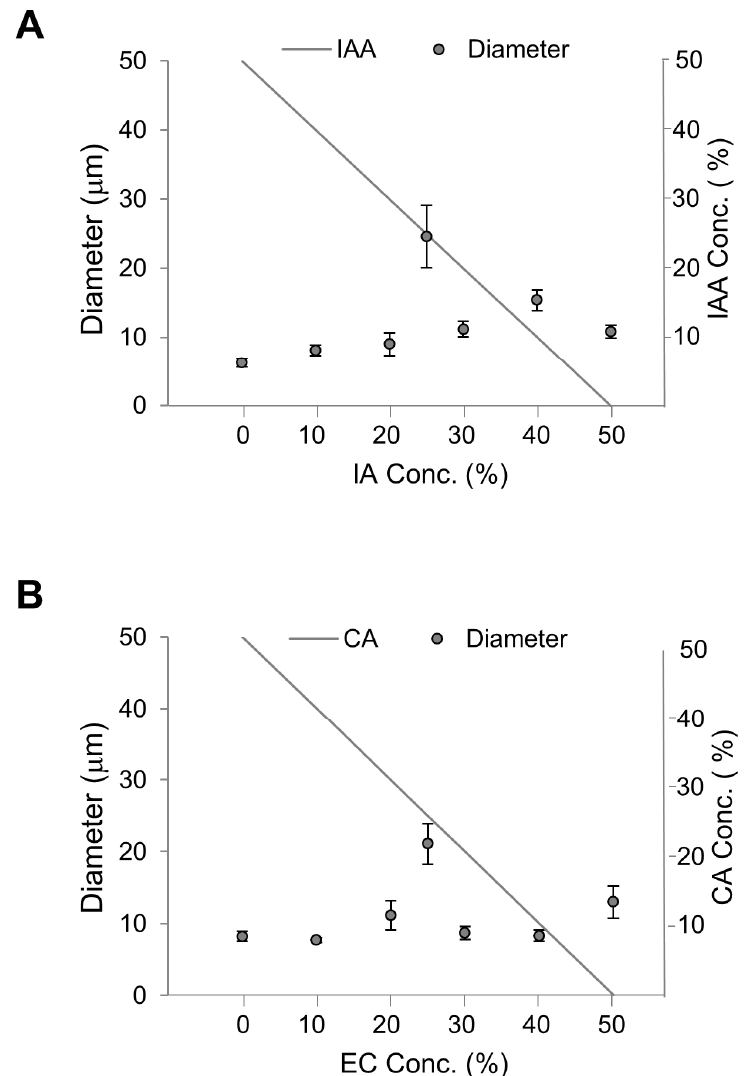
Figure 8. Diameters of vesicles containing key flavors. The total flavor concentration was constant at 50%, and the ratio of flavor-to-precursor was variable. ( A ) Diameters of vesicles containing isoamyl acetate (IA) and isoamyl alcohol (IAA). ( B ) Diameters of vesicles containing ethyl caproate (EC) and caproic acid (CA).